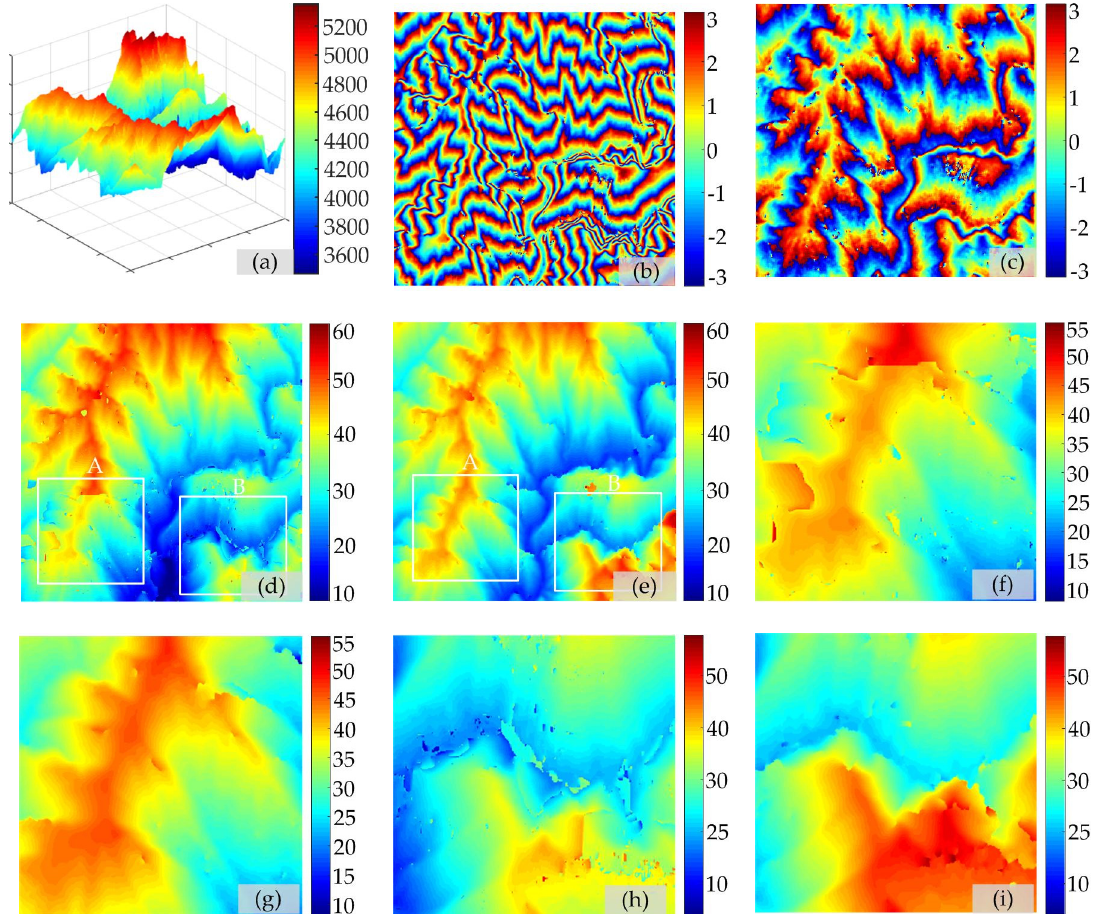
Figure 6. ( a ) 3-D display of the Advanced Land Observing Satellite (ALOS) Phased Array type L-band Synthetic Aperture Radar (PALSAR) digital elevation models (DEM). ( b ) Real interferogram with long normal baseline. ( c ) Real interferogram with short normal baseline. ( d ) PU result of (b) obtained